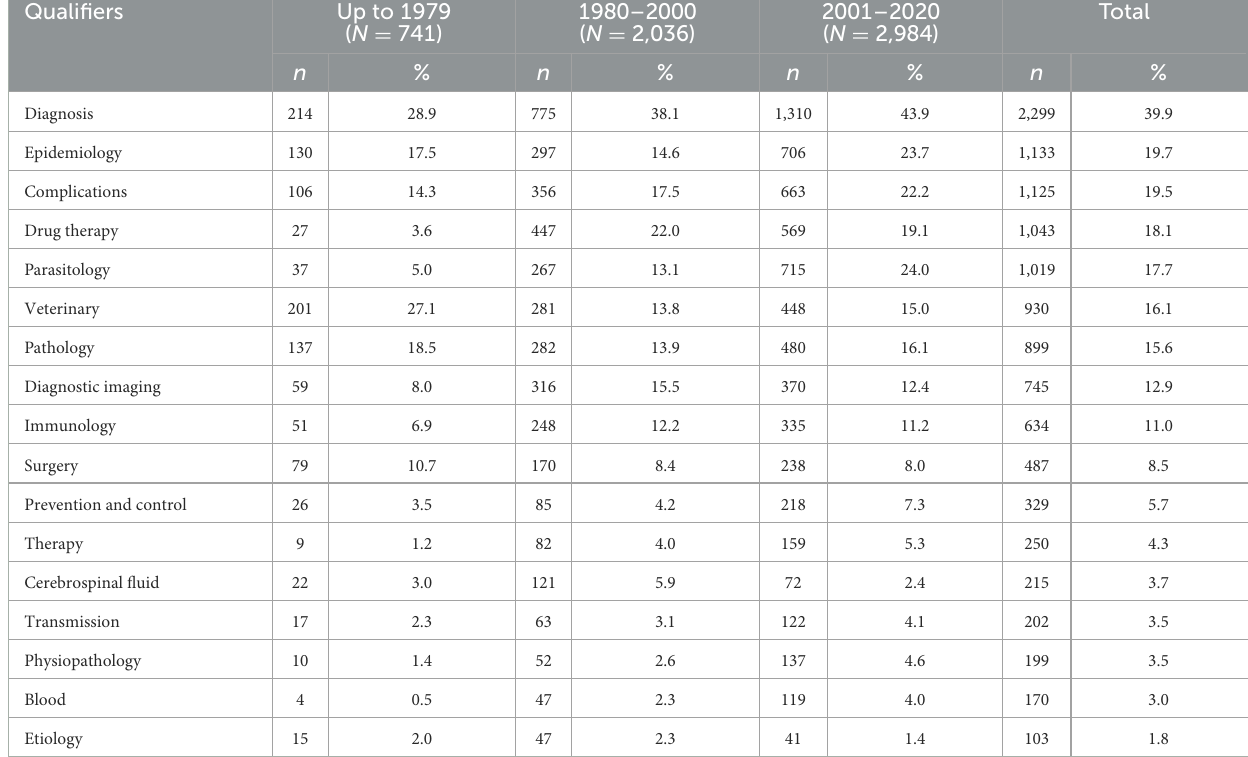
TABLE 6 Qualifiers accompanying the MeSH descriptors for cysticercosis and neurocysticercosis on documents indexed in MEDLINE.